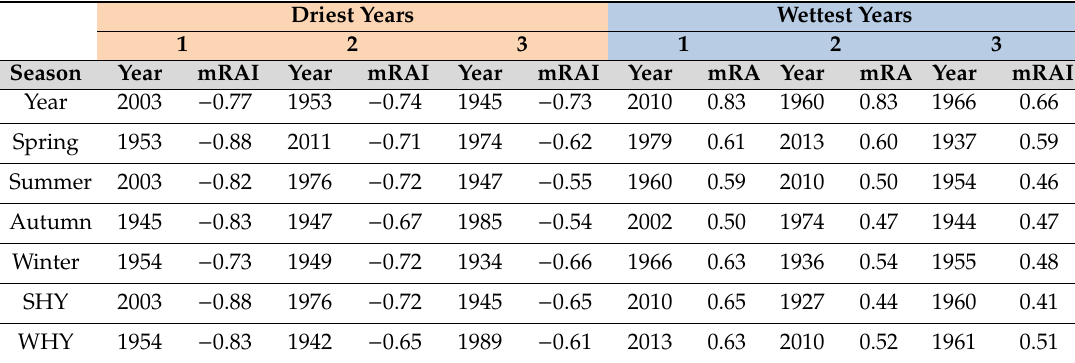
Table 4. Overview over the three driest and wettest years, seasons, and half years (SHY: summer half year, WHY: winter half year) for the 220 stations covering Europe, as identified by the mRAI